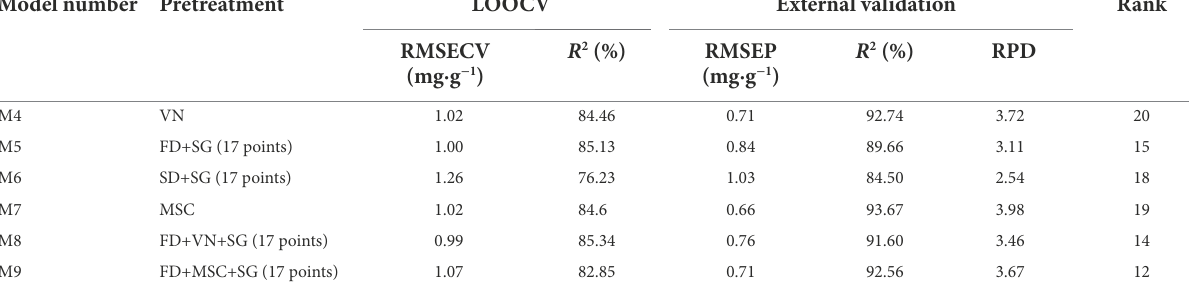
TABLE 3 Optimization results of spectra pretreatment in calibration models. Model number